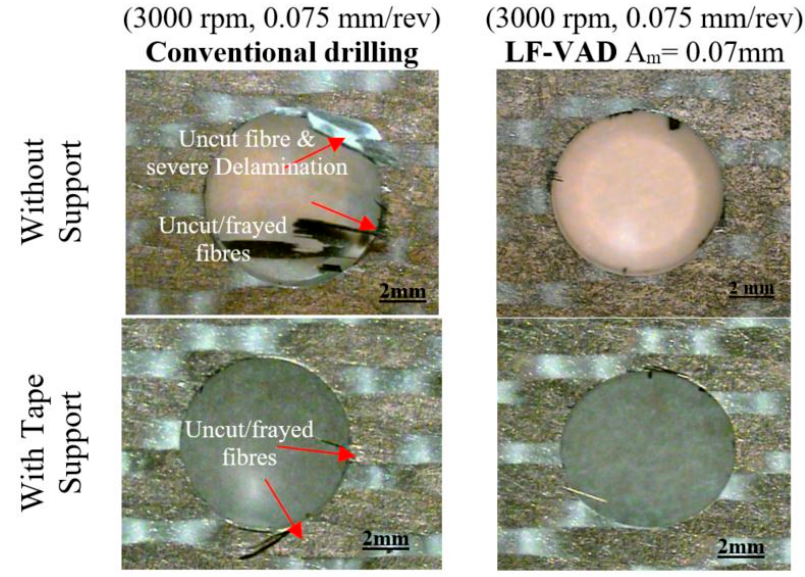
Figure 11. Effect of cutting technique, adhesive back support, and machining parameters on the exit delamination.